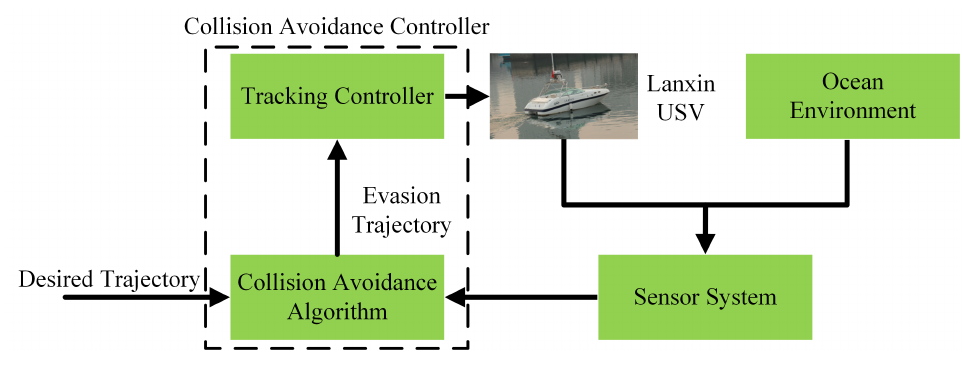
Figure 6. The collision avoidance